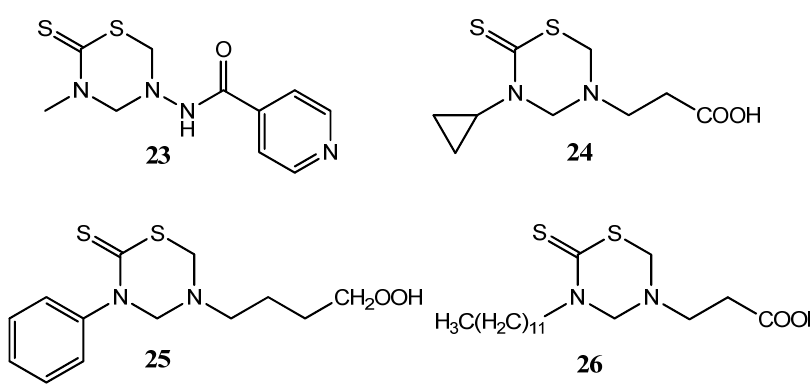
Figure 8. THTT derivatives with antuberculosis